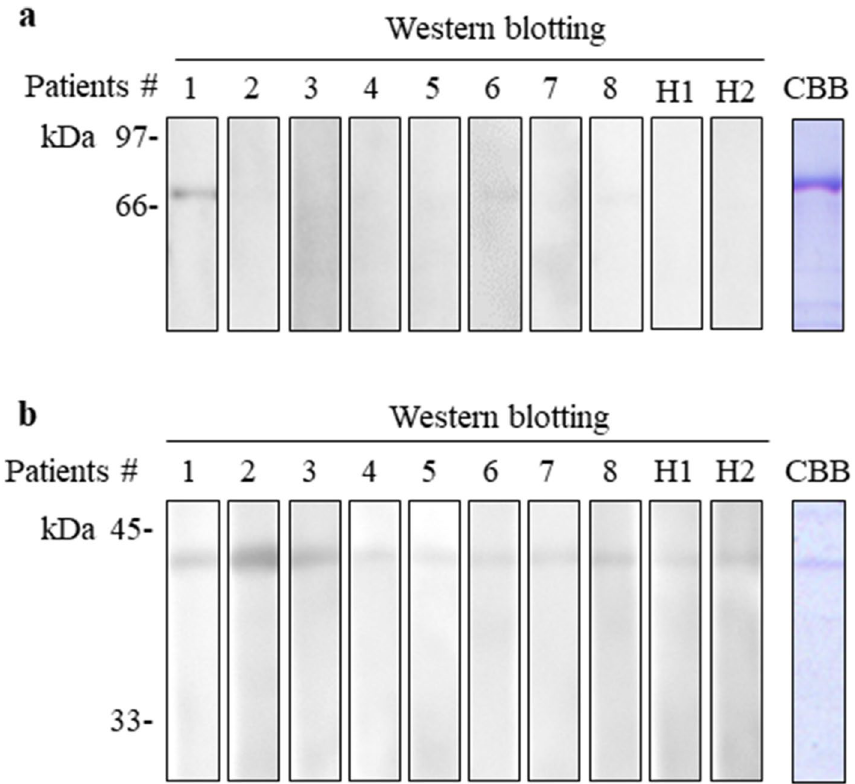
Figure 5. Immunoblot analysis of P75 homologue and FBPA proteins isolated from L. vannamei. Samples of purified native P75 homologue ( a , 0.24 µg) and FBPA ( b , 1.2 µg) were subjected to SDS-PAGE and either stained with CBB or immunoblotted with 1:10 dilutions of sera from shrimp-FDEIA patient nos. 1–8 and healthy subjects (H1 and H2). Full-length blots and gels are presented in Supplementary Figure